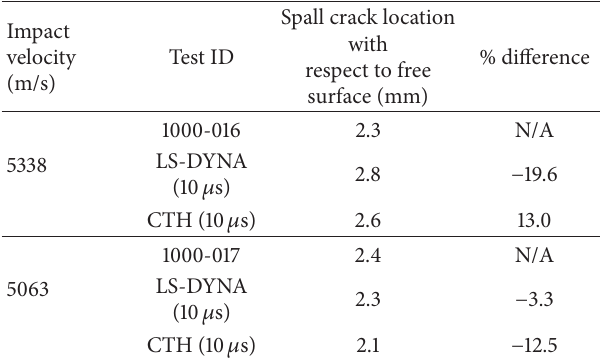
Table 7: Comparison of spall crack in